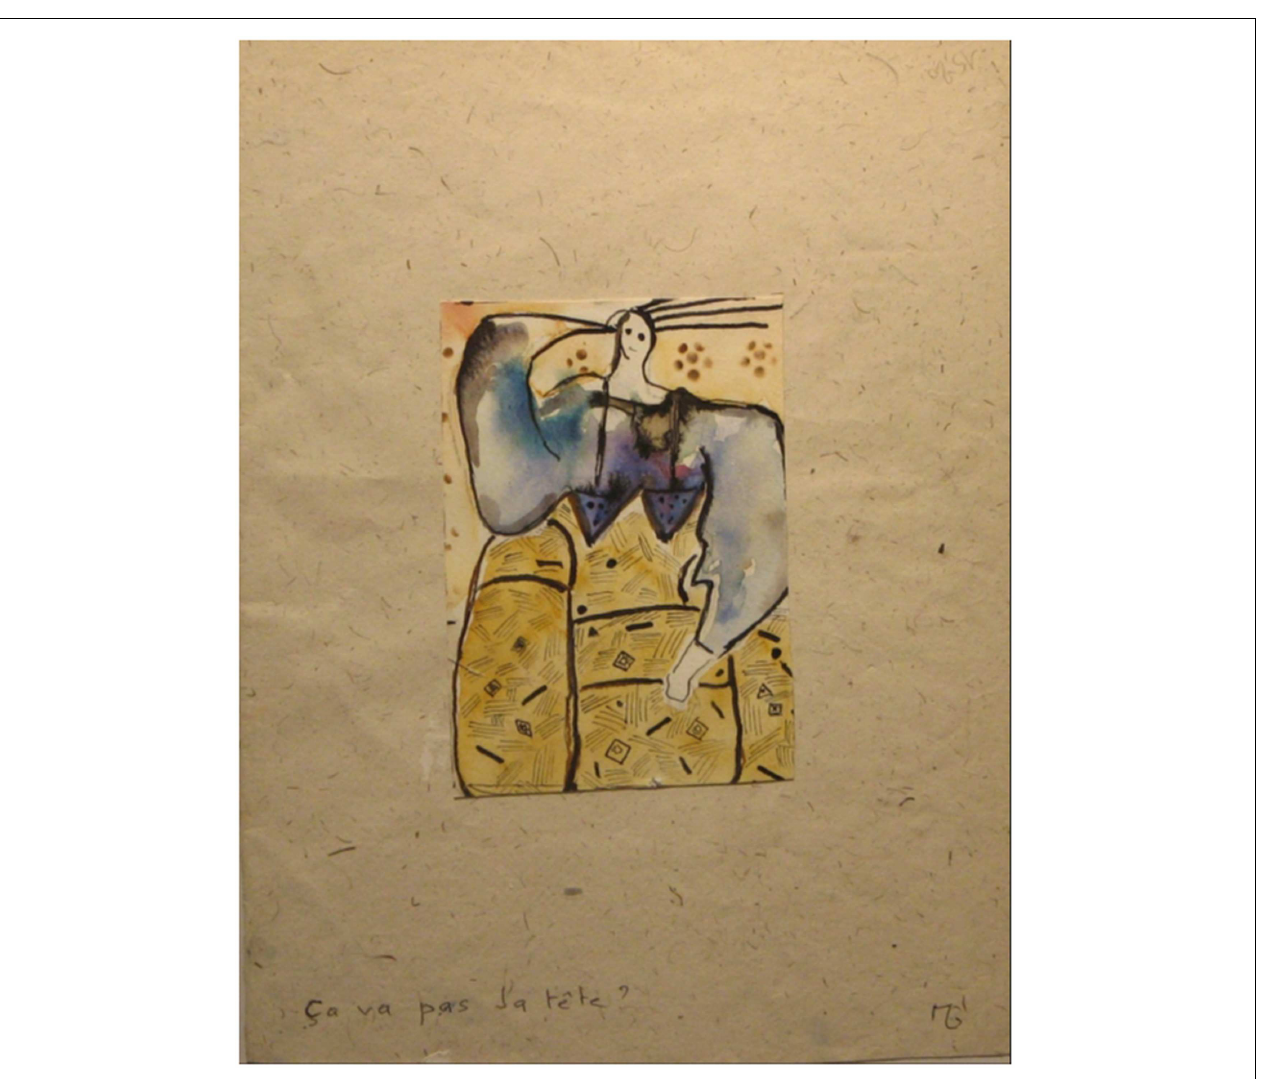
FIGURE 4 |Addictive period .The painting bears the inscription “Am I going nuts?” illustrating maintenance of self-criticism by the patient.